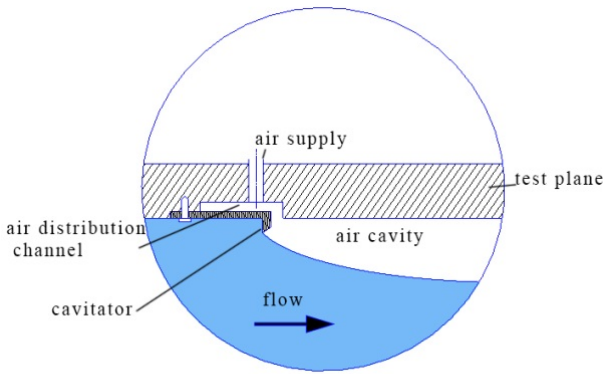
Figure 7. Slotted nozzle.